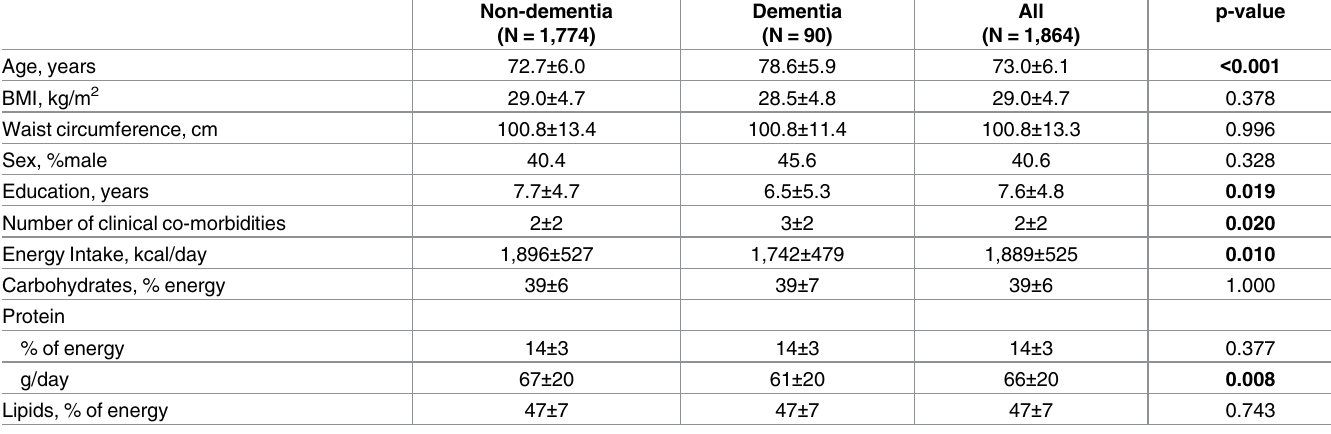
Table 1. Demographic, anthropometric, medical characteristics and dietary intake of the study participants by cognitive